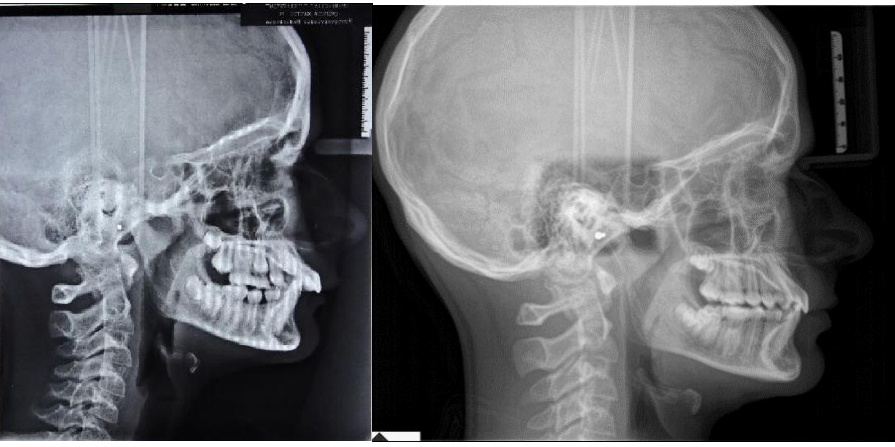
Figure 6. Cephalometric changes .